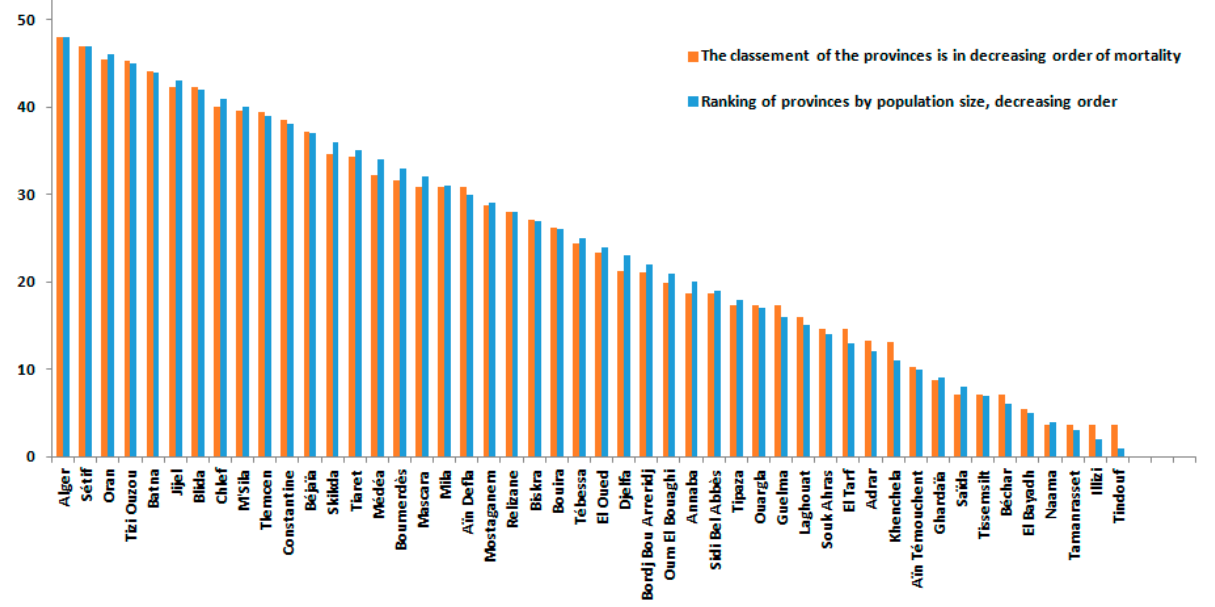
Figure 5. Distribution of COVID-19 mortality risks in the Northern provinces.